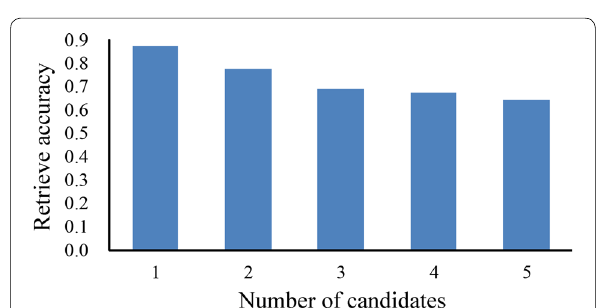
Fig. 5 Accuracy of the first one to five retrieved substructures compared to the